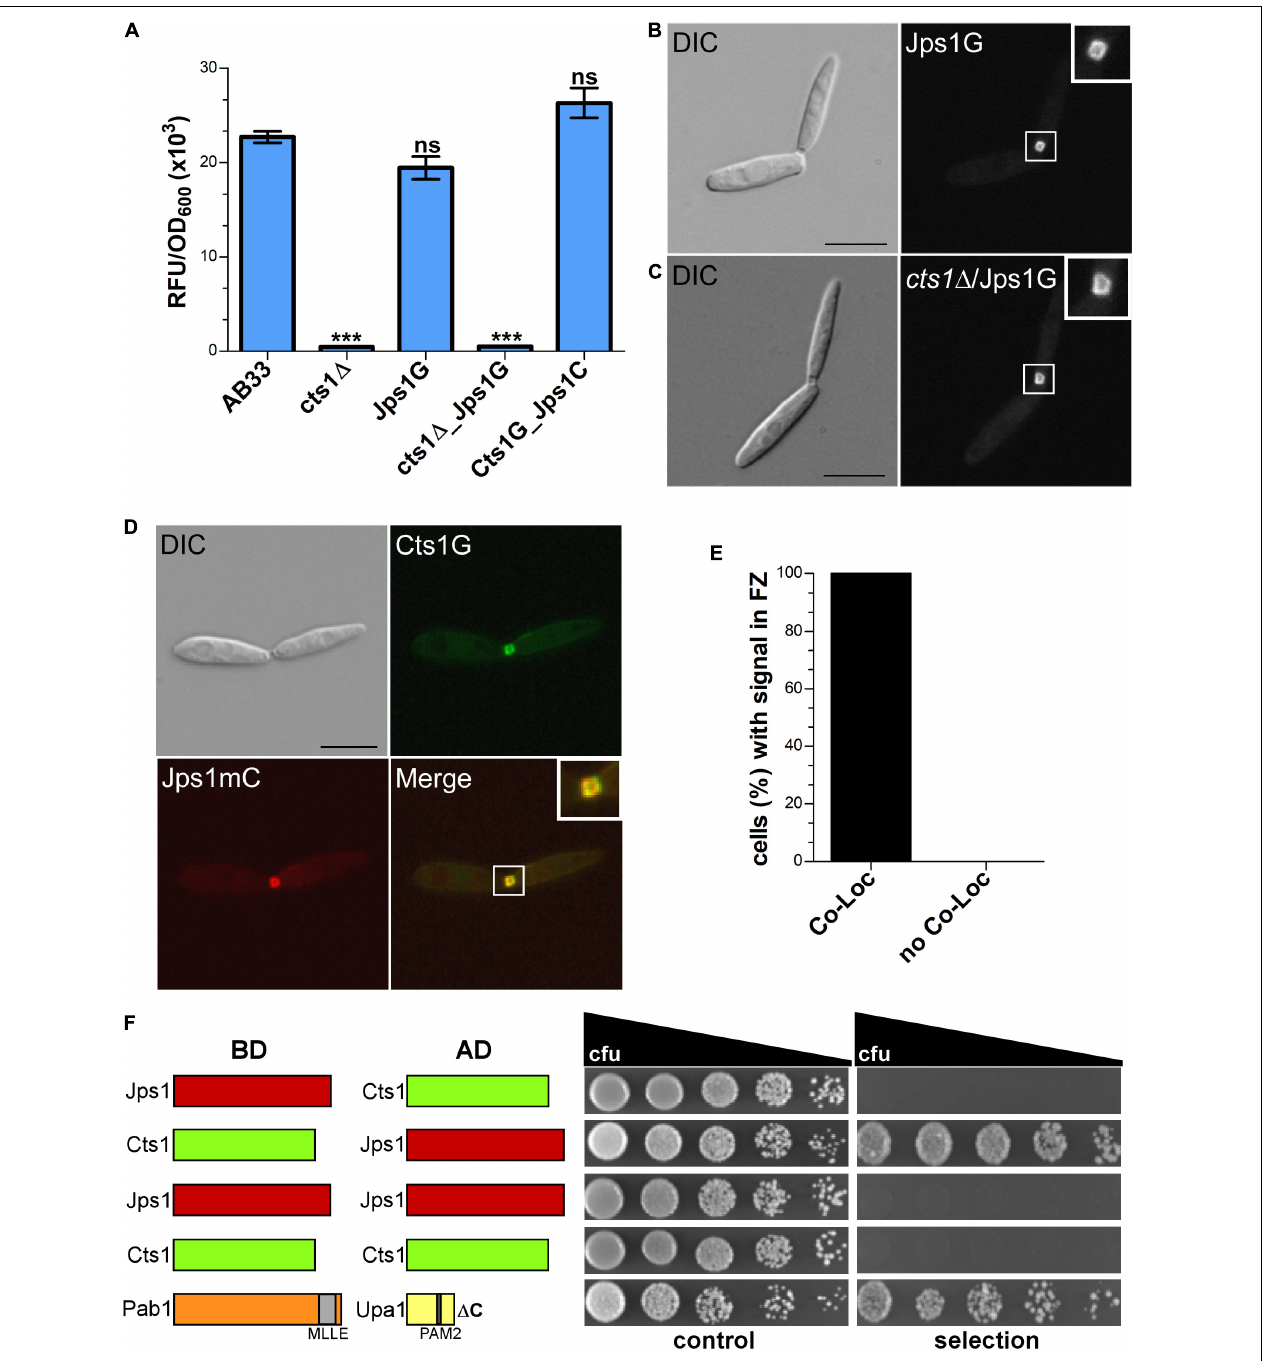
FIGURE 5 | Jps1 co-localizes with Cts1 in the fragmentation zone. (A) Extracellular Cts1 activity of indicated strains. AB33cts1 (cid:49) lacking Cts1 was used as negative control. The Jps1mC fusion protein is functional. The assay was conducted in five biological replicates. Error bars indicate standard deviation. *** P -value 0.001; n.s., not significant (two sample t -test). (B) Localization of Jps1G in AB33. The protein accumulates in the fragmentation zone of dividing cells. Scale bar, 10 µ m. (C) Localization of Jps1G in AB33cts1 (cid:49) . Localization of Jps1 in the fragmentation zone is not altered in the absence of Cts1. Scale bar, 10 µ m. (D) Micrographs of strain AB33Cts1G/Jps1mC indicating co-localization of Cts1G and Jps1mC in the fragmentation zone. (E) Quantification of co-localizing signals (Co-Loc) and not co-localizing signals (No Co-Loc) of strain AB33Cts1G/Jps1mC in the fragmentation zones of 970 cells observed. The experiment was conducted in three biological replicates with identical outcomes. Not a single cell with differing observations than indicated was detected. (F) Yeast-two hybrid assays to analyze protein:protein interactions between Jps1 and Cts1. For the positive control using strains producing Pab1 and Upa1 a weak interaction had been shown before (Pohlmann et al., 2015). BD, binding domain; AD, activation